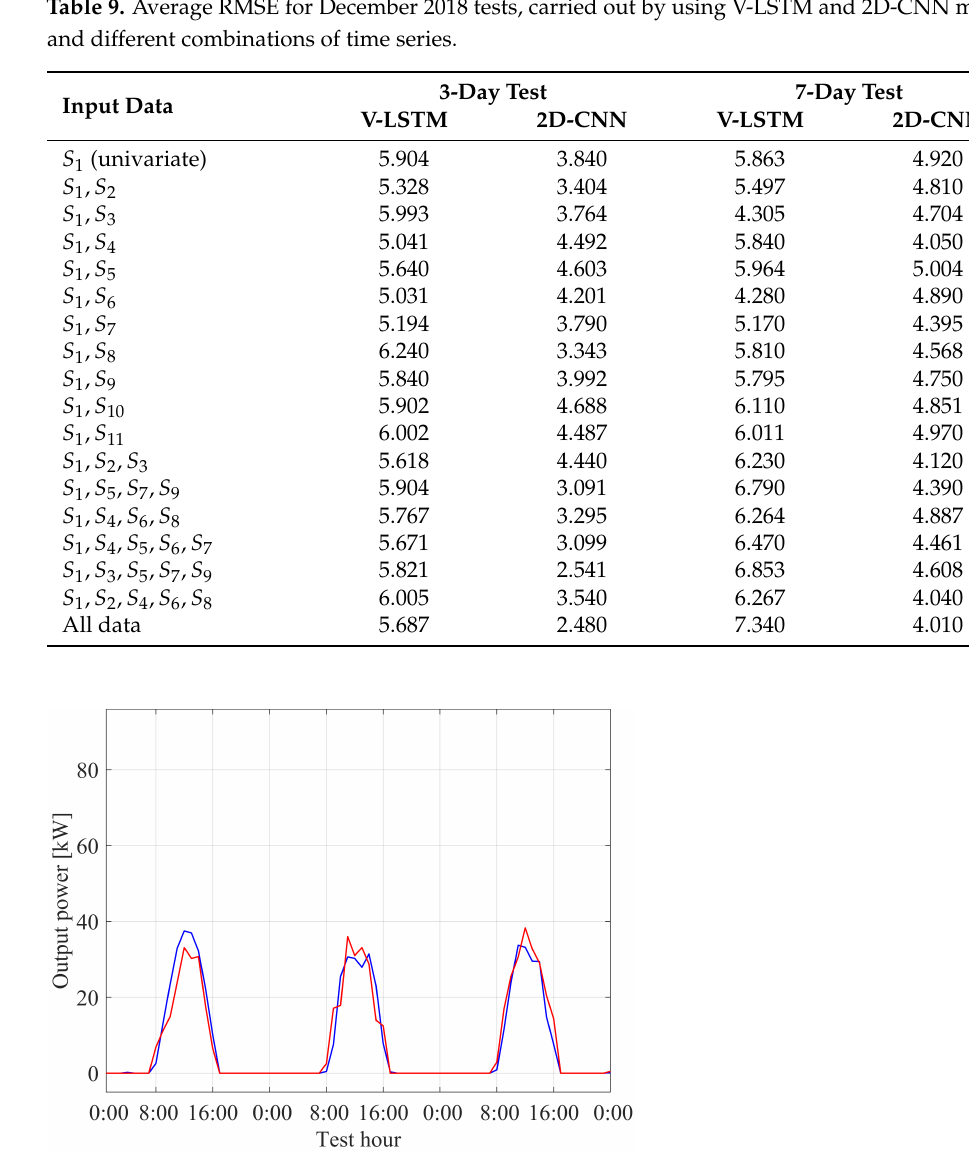
Figure 9. Predicted (red) and real (blue) value of output power in the mid of December 2018, by using the 2D-CNN approach with the univariate input on the 3-day test set (see Table 9, row 1, column